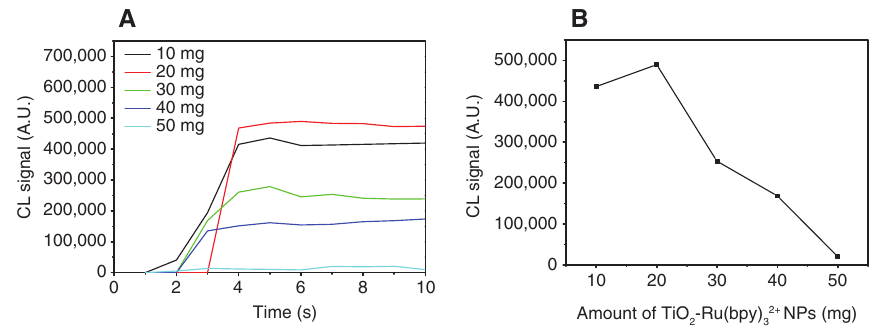
-Ru(bpy) 32 + NPs. (B) The effect of the amount of TiO 2